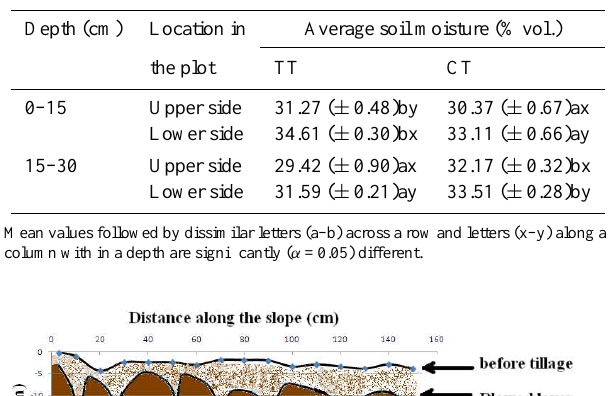
Table 1. Mean soil moisture content at different layers in response to traditional and conservation tillage in wheat at Enerta, Ethiopia.